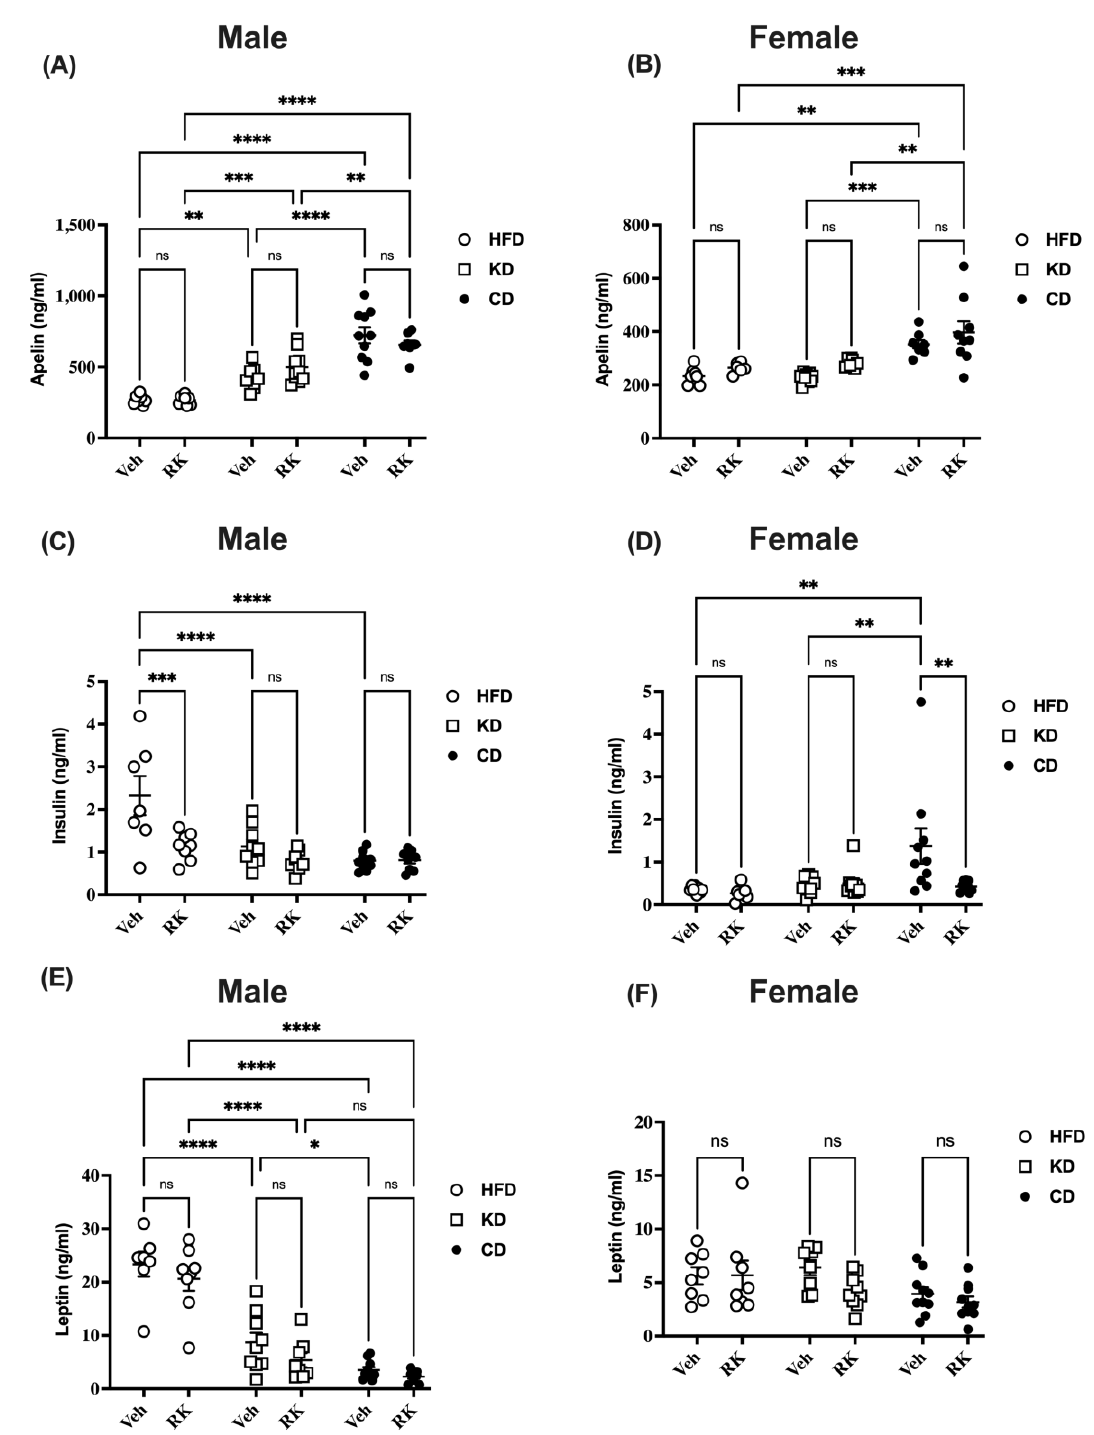
Figure 3. Plasma apelin ( A , B ), insulin ( C , D ) and leptin ( E , F ) levels in overweight/obese male and female mice after 4 weeks of daily dosing and diet feeding. * p < 0.05; ** p < 0.01; *** p < 0.001; **** p < 0.0001; ns, not significant; Two-way analysis of variance (ANOVA) was performed, followed by Newman-Keuls post hoc tests when justified; p < 0.05 was considered statistically significant. N = 8-10 mice/group. High-fat diet (45%fat), HFD; ketogenic diet (80%fat), KD; control diet (10%fat), CD; vehicle, Veh; raspberry ketone, RK.